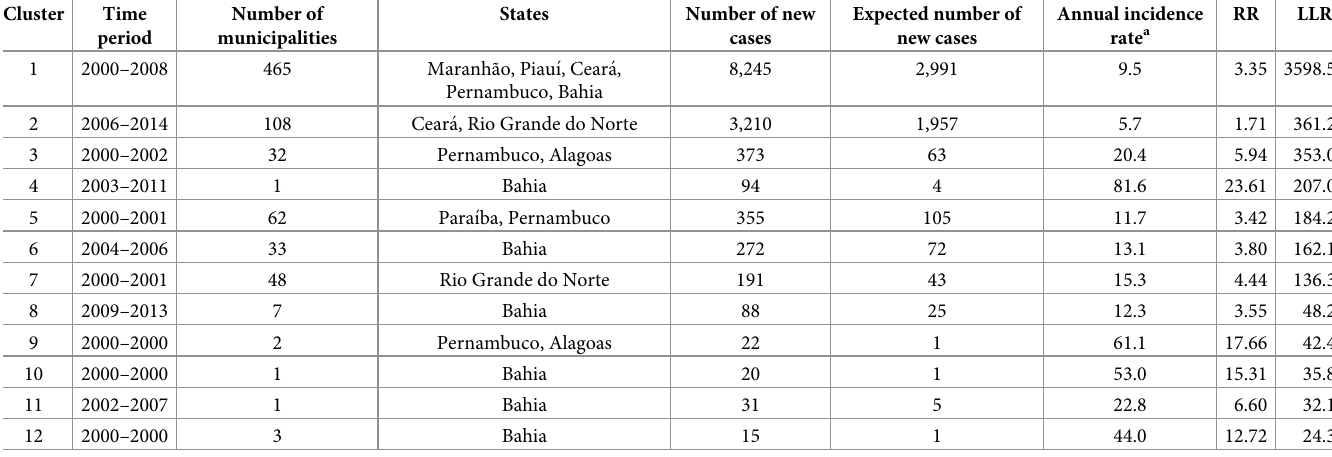
RR: relative risk for the cluster compared with the rest of the region; LLR: likelihood ratio. a LV incidence rate (per 100,000 inhabitants) during the clustering